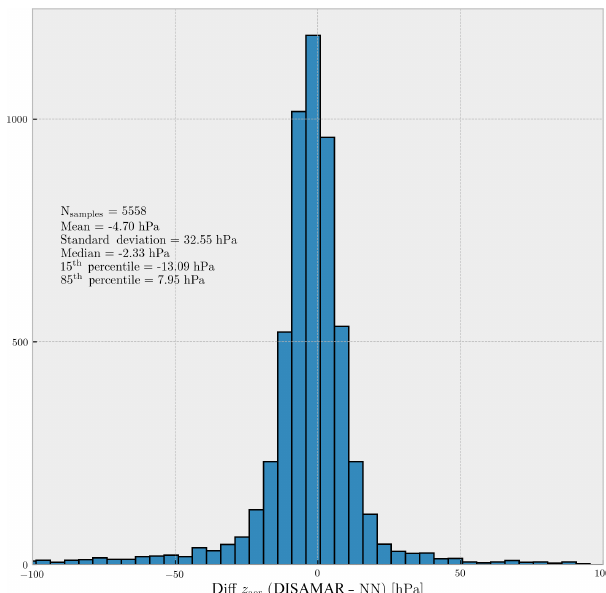
Figure 7. Histogram of biases (retrieved minus true) for scenes in the synthetic experiment for which either NN converges to a so- lution (red bar plot) and DISAMAR does not, or DISAMAR con- verges to a solution (blue bar plot) and NN does